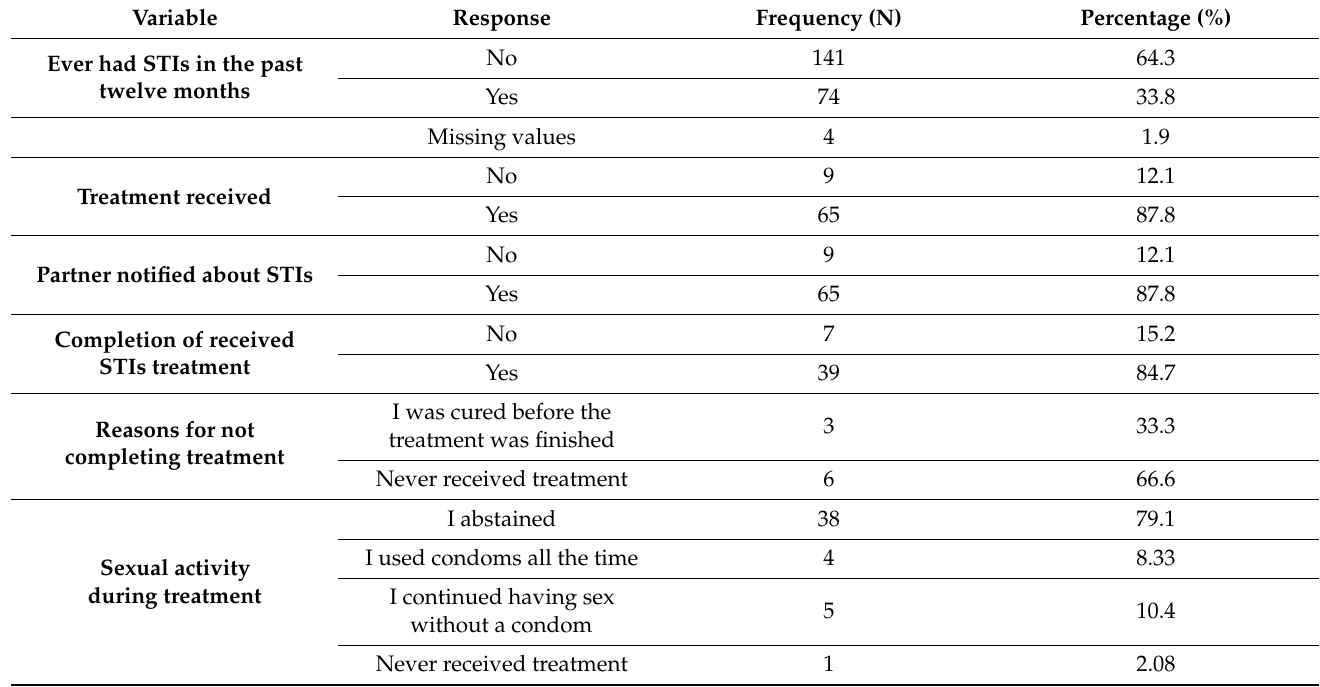
Table 10. STIs, treatment and partner notification (n = 219).